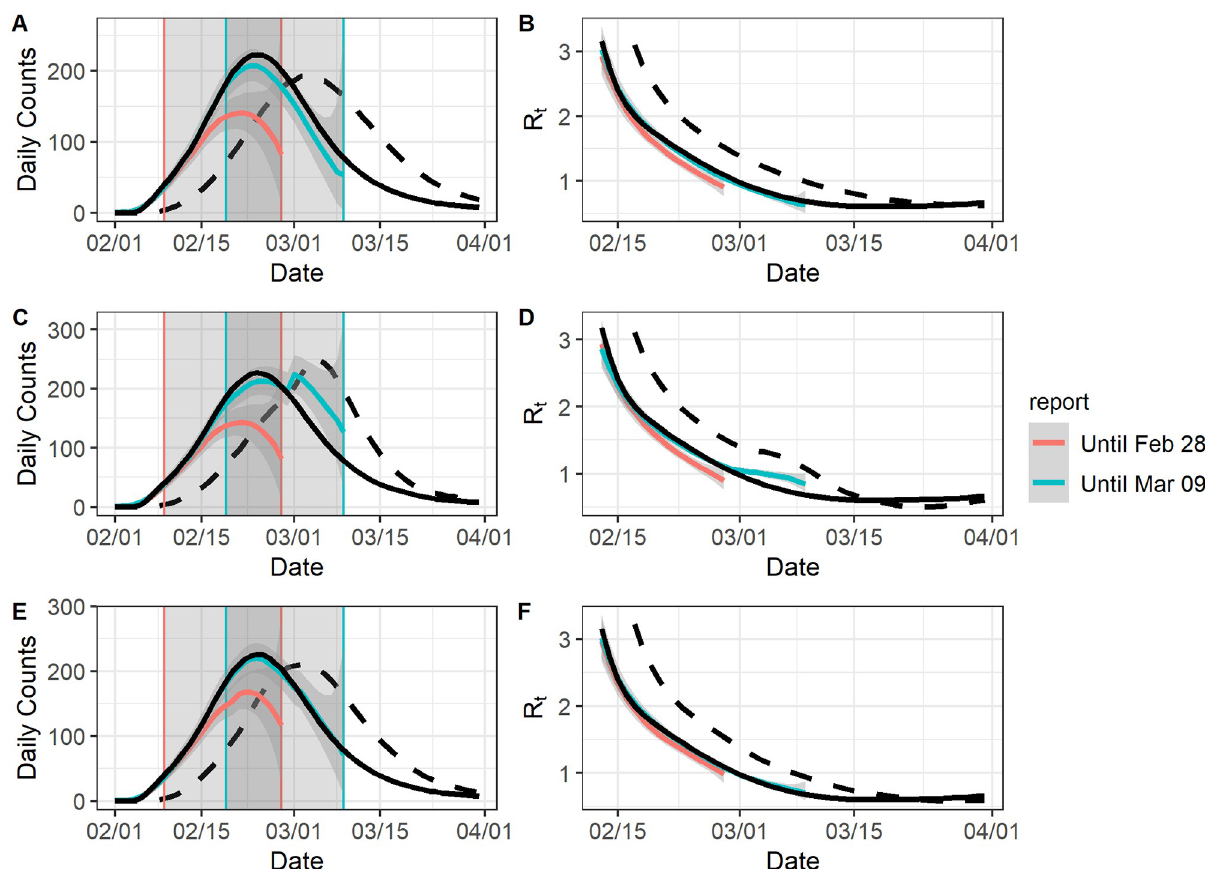
Fig 4. The model fit for an ongoing epidemic wave. For all graphs: the black solid curve corresponds to estimates based on the known epidemic curves and the black dashed curve corresponds to estimates based on the reported curves. The grey-shaded region superimposed on the curve depicts the 95% Bayesian credible interval. The colored curves represent different ending dates for line-list data, and their nowcasting regions are displayed as the gray- shaded areas with boundary lines in their corresponding colors. All values were averaged over 1000 simulated datasets. All values were averaged over 1000 simulated datasets with the correct l . A: The epidemic curve estimates if the reporting delay distribution was unchanged. B: The reproduction number estimates if the reporting delay distribution was unchanged. C: The epidemic curve estimates if the reporting delay distribution was sharply improved. D: The reproduction number estimates if the reporting delay distribution was sharply improved. E: The epidemic curve estimates if the reporting delay distribution was gradually improved. F: The reproduction number estimates if the reporting delay distribution was gradually improved.